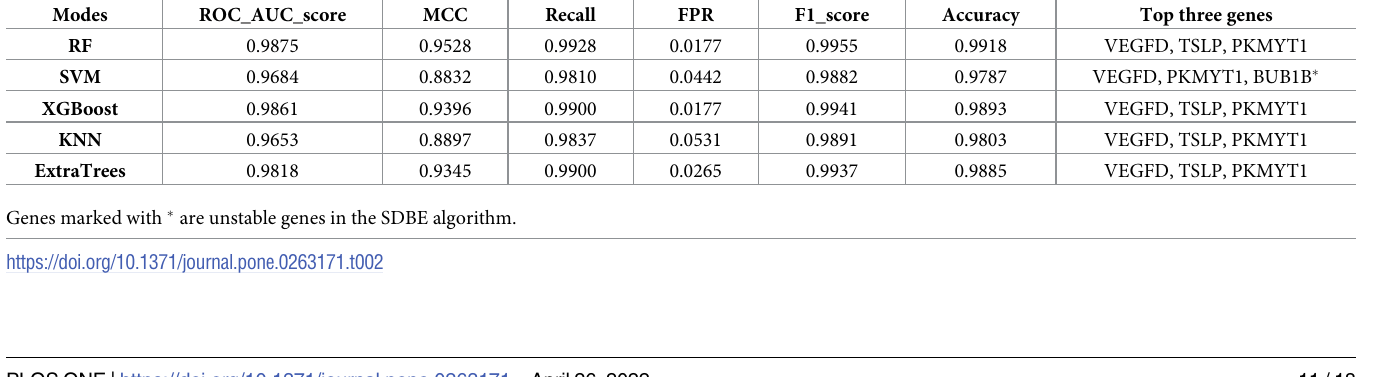
Table 2. MCC as the object of difference analysis: 10-fold cross-validation classification metrics of the top three genes. Modes ROC_AUC_score MCC Recall FPR F1_score Accuracy Top three genes